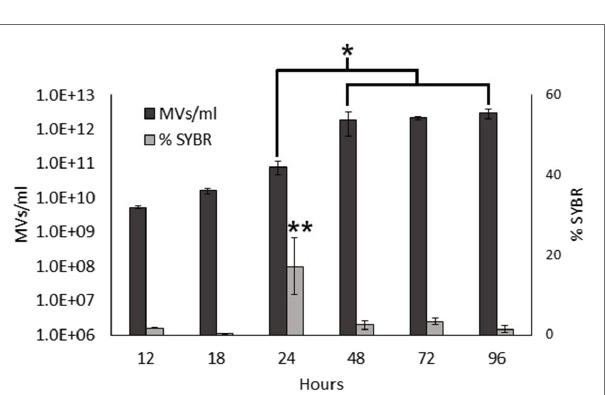
FIGURE 2 | Nucleic acid content in S. vesiculosa M7 T MVs. Bar graph representing the total MV concentration (only labeled with FM4-64) and the percentage of nucleic acid-containing MVs (simultaneously labeled with FM4- 64 and SYBR ™ Gold) during growth. n = 3, Statistical analysis was done using ANOVA test, * and ** p <